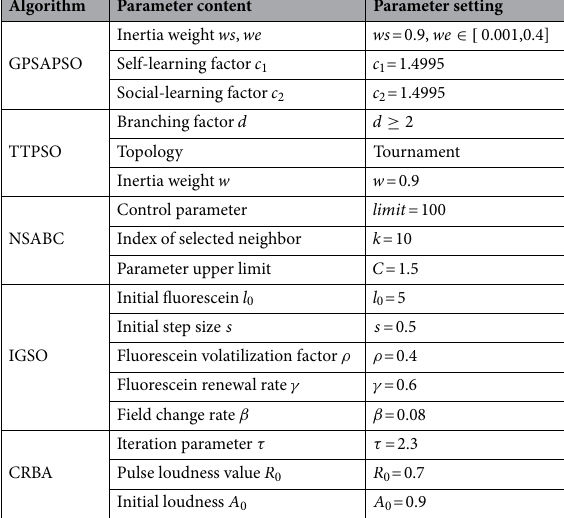
Algorithm Parameter